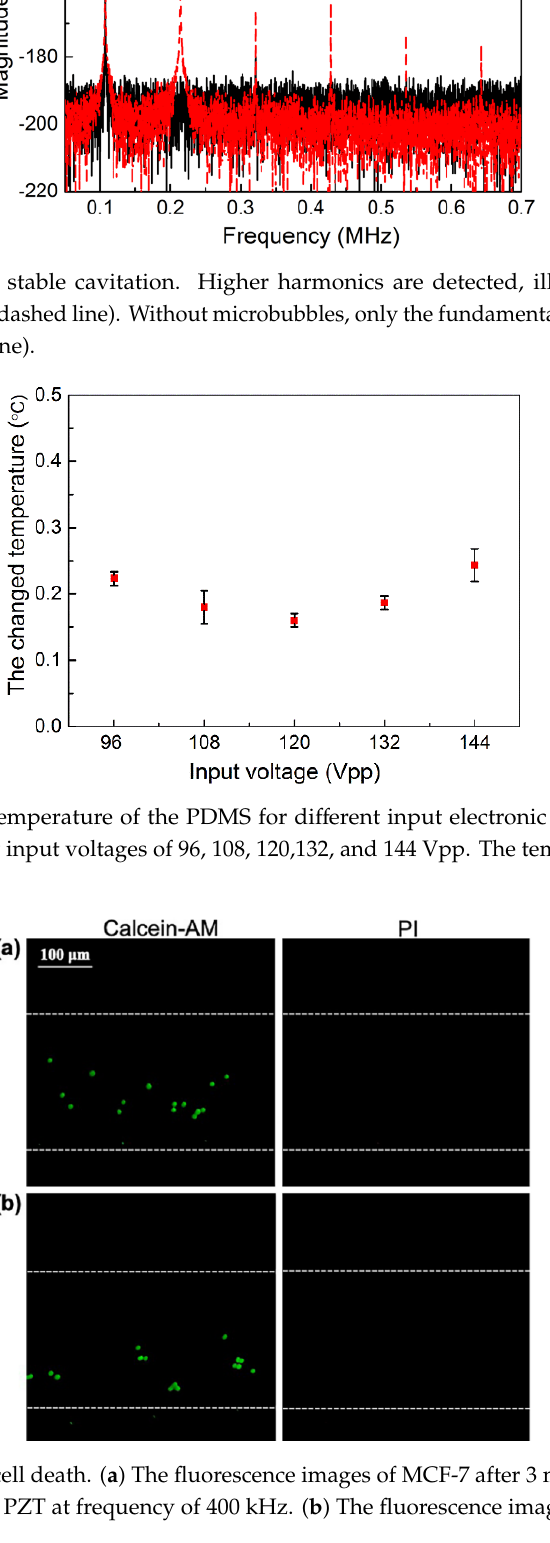
Figure 5. Microbubble stable cavitation. Higher harmonics are detected, illustrating that stable cavitation occurred (red dashed line). Without microbubbles, only the fundamental frequency spectrum can be detected (black line).